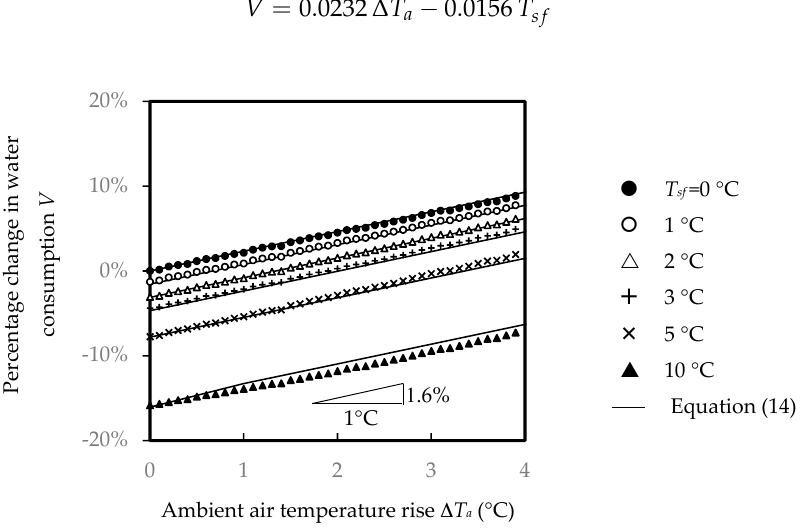
Figure 3. Percentage change in shower water consumption against ambient air temperature rise.